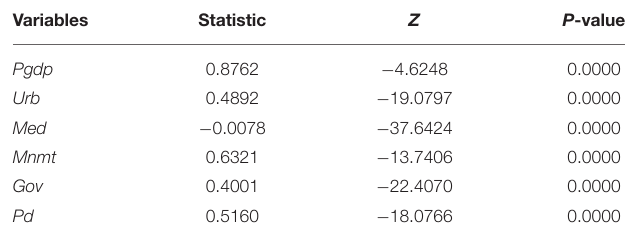
TABLE 5 | Panel unit root inspection results.